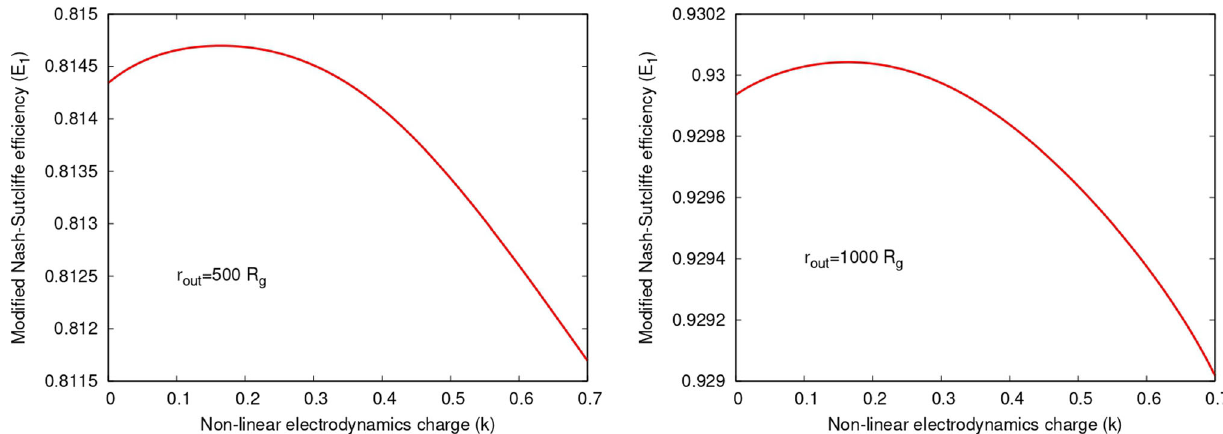
Fig. 4 In the figure the modified Nash–Sutcliffe Efficiency E 1 is plot- ted with the non-linear electrodynamics charge parameter k . In the left panel E 1 is plotted for r out = 500 r g while E 1 calculated with r out = 1000 r g is shown in the right panel. In both cases, E 1 maximizes